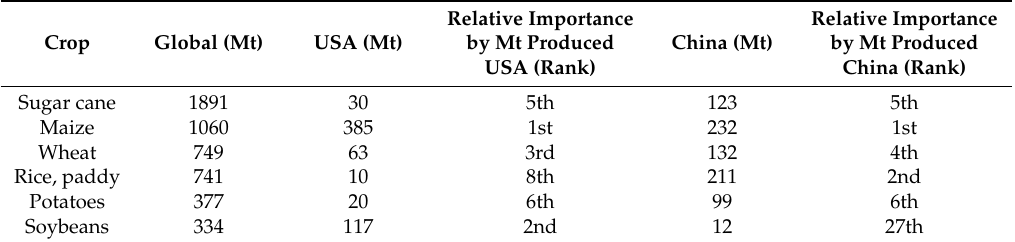
Table 1. Crop production in 2016 [6].